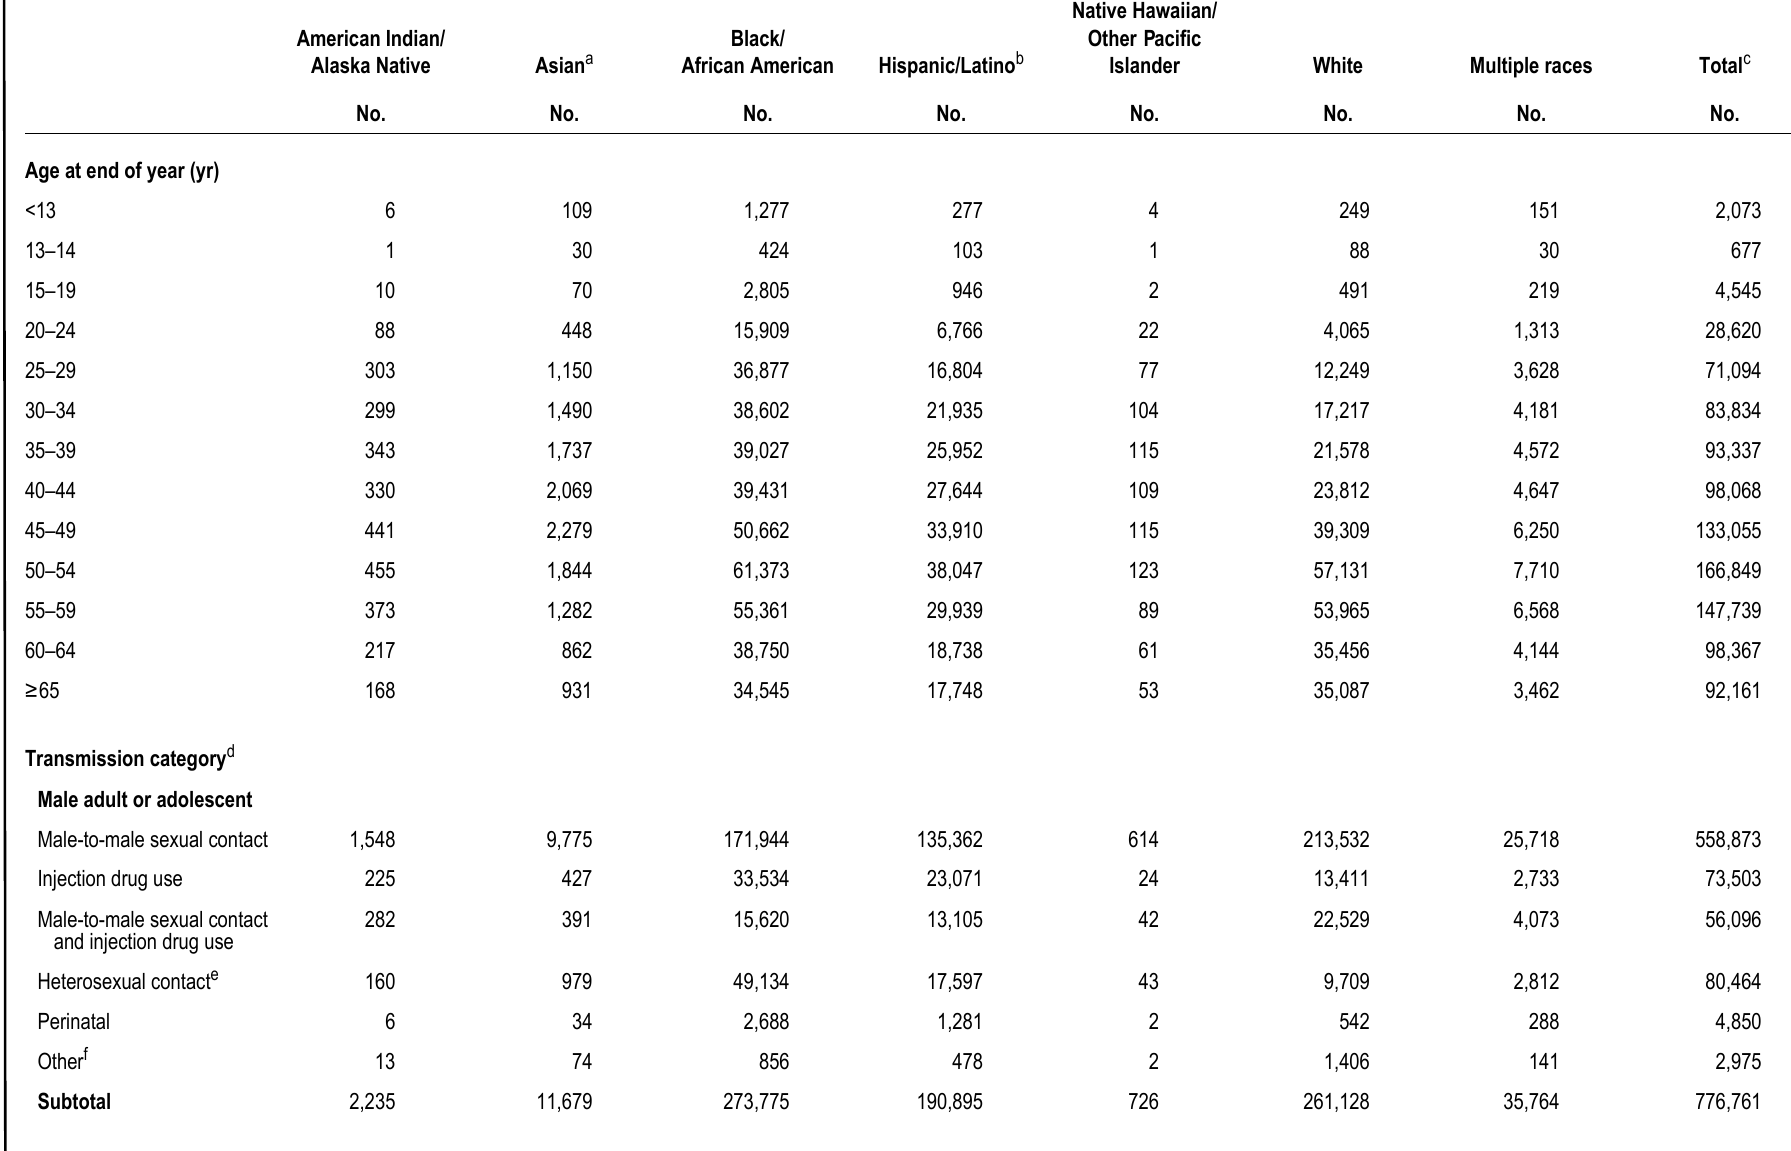
Table 24b. Persons living with diagnosed HIV infection, by race/ethnicity and selected characteristics, year-end 2017—United States and 6 dependent areas Native Hawaiian/ American Indian/ Black/ Other Pacific Alaska Native Asian a African American Hispanic/Latino b Islander White Multiple races Total c No. No. No. No. No. No. No.